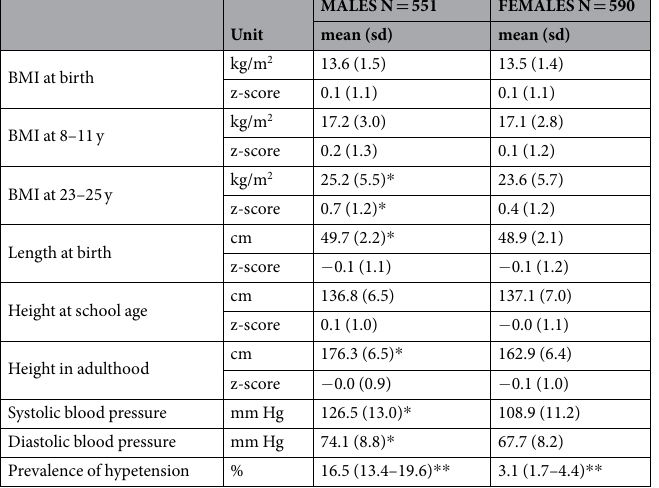
Table 2. Body mass index (BMI), length/height and blood pressure, in a population-based birth cohort born in 1978–79 in Ribeirao Preto, Brazil, by sex. sd = standard deviation. * t test p < 0.001; ** chi-square test < 0.001; 95% confidence interval for the prevalence